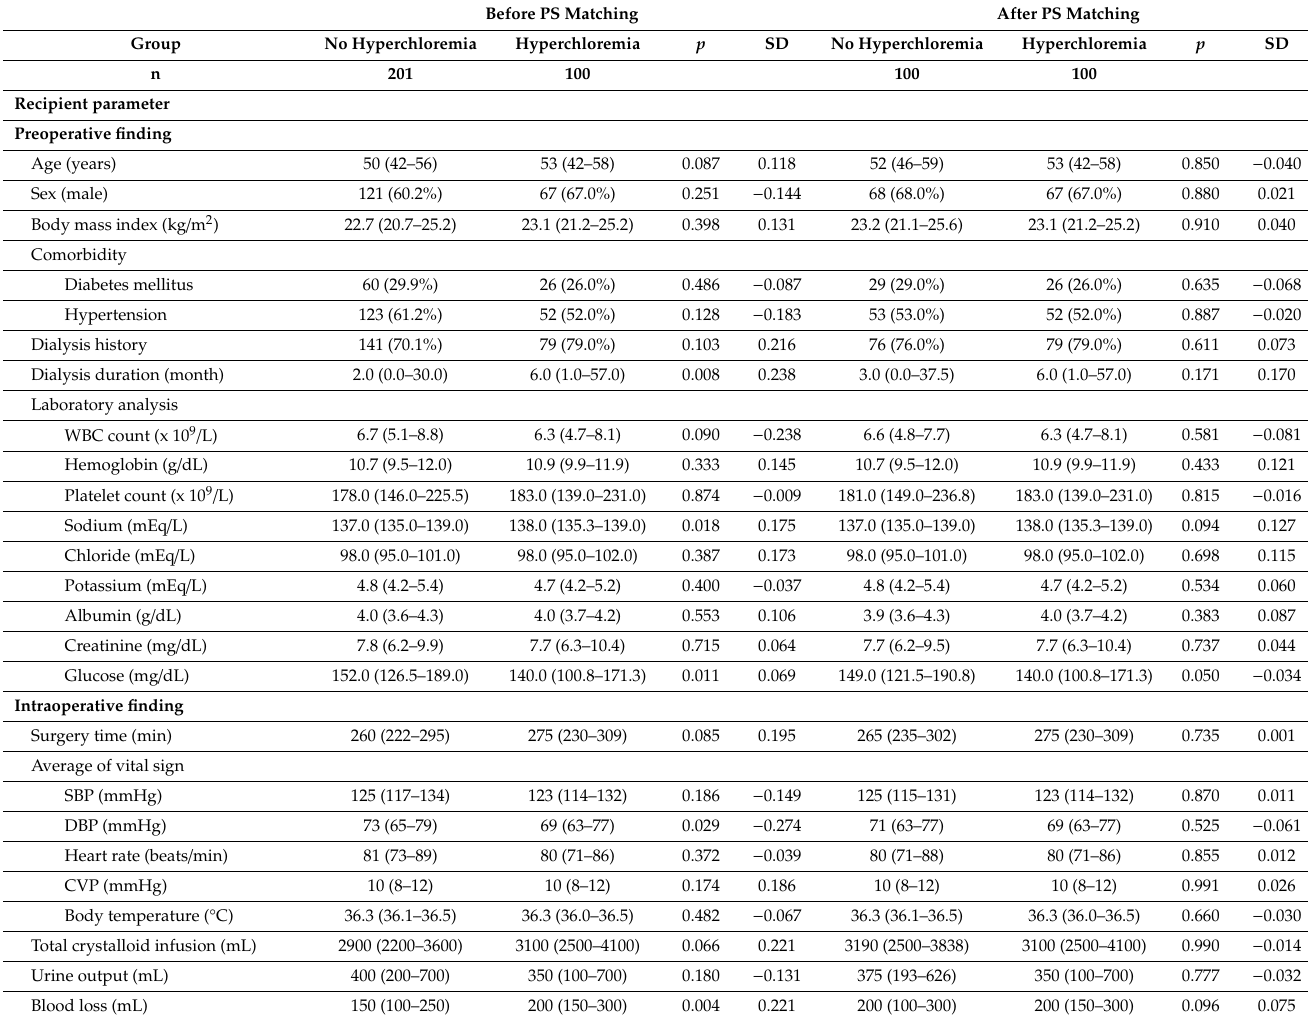
Table 2. Comparison of clinical perioperative factors between the non-hyperchloremia and hyperchloremia groups before and after propensity score matching